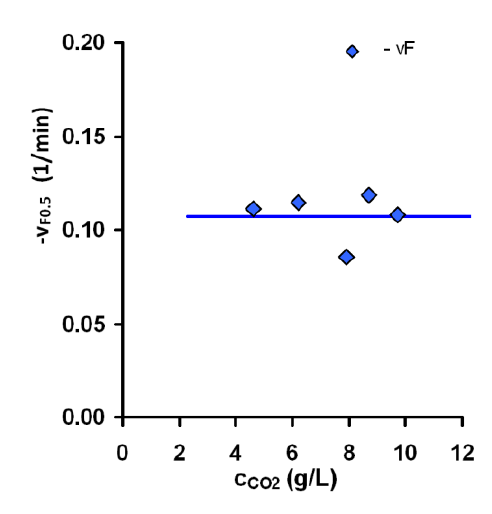
Fig. 9. Foam decay – effect of CO 2 content: parameter v F0.5 .